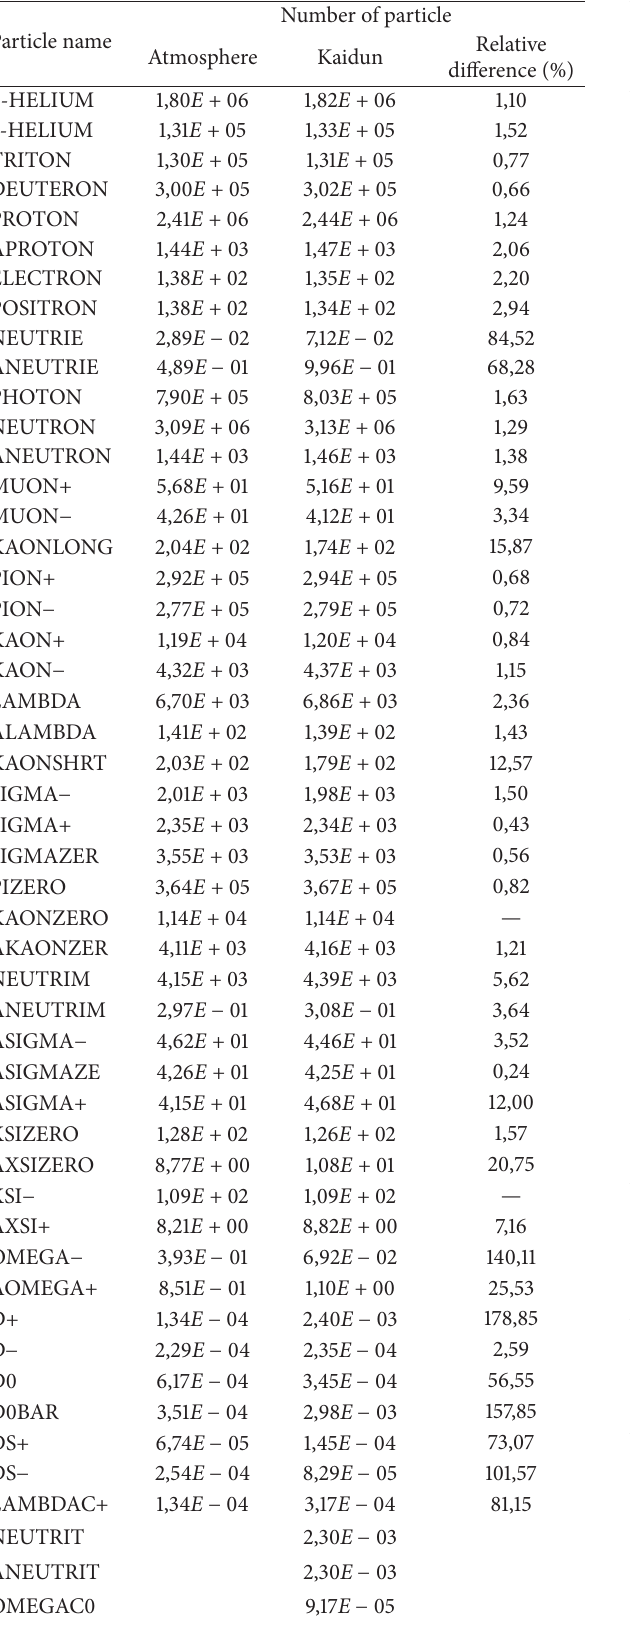
Table 4: Number of secondaries generated in inelastic interactions. Table 5: Decay products generated in inelastic